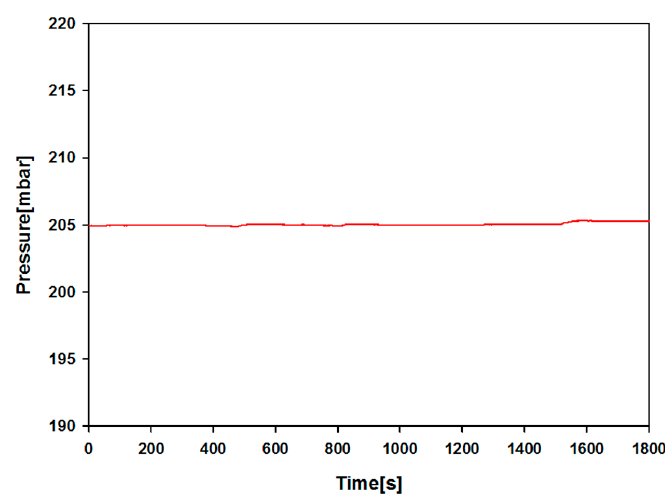
Figure 8. Air tightness test results over 30 min. A change of 0.3 × 10 − 3 bar is within limits.